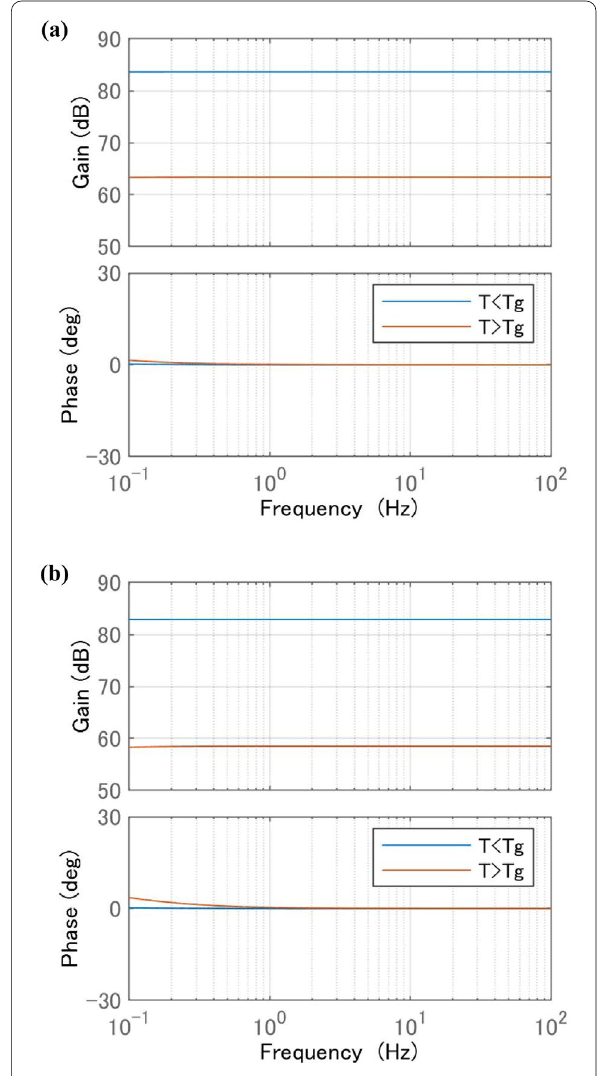
Fig. 16 Frequency responses of transfer function obtained using Method 2. a #1. b